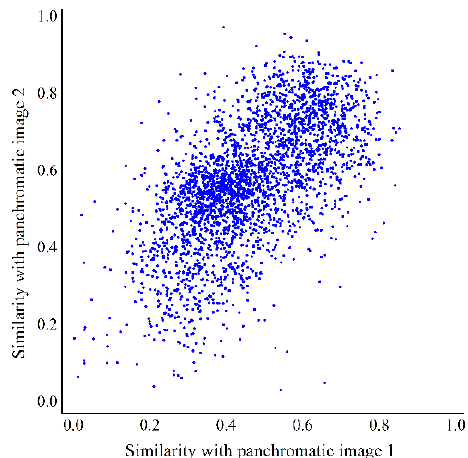
Figure 4. Scatter plot for two similarities between the query multispectral image and two different viewing panchromatic images of a stereo